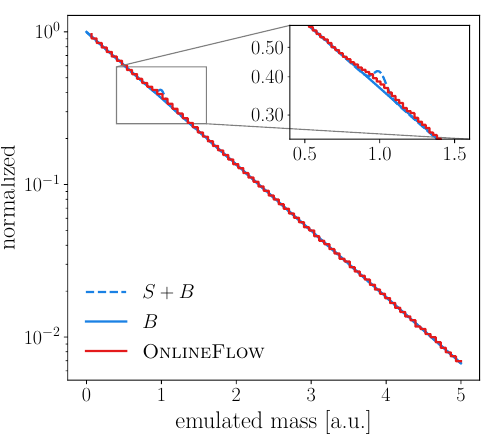
Figure 4: Illustration of our 1-dimensional, exponentially falling, mass spectrum. B denotes background events, S is the signal, following the truth distributions of Eq.(1). The O NLINE F LOW histogram shows 10M events generated after training on S + B